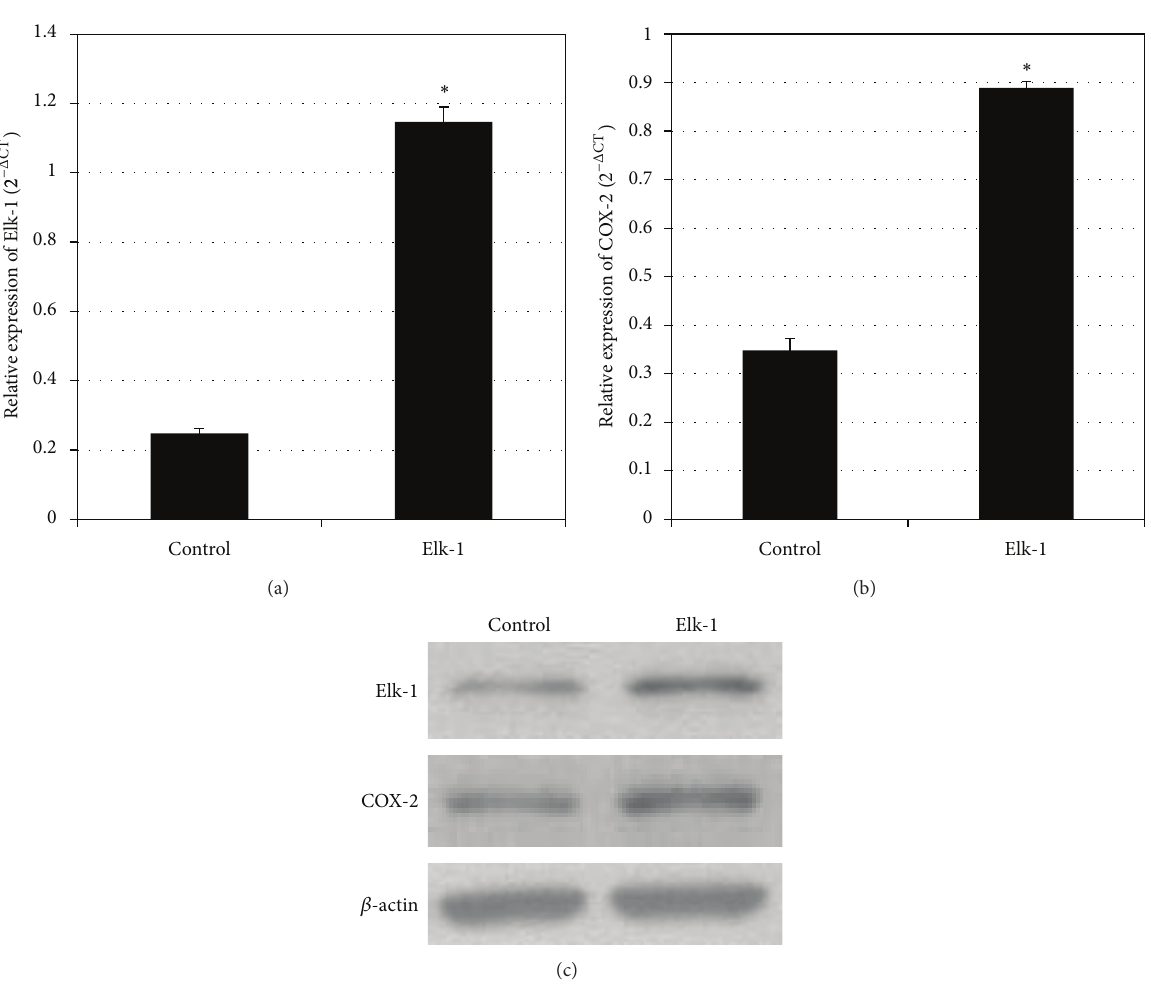
Figure 1: Elk-1 upregulated COX-2 gene expression. (a and b) Elk-1 and COX-2 mRNA levels were determined by quantitative real-time RT- PCR. Relative mRNA expression was expressed as mean ± SEM. ∗ 𝑃 < 0.001 versus control. (c) Elk-1 and COX-2 protein levels were assayed by Western blot analysis. 𝛽 -actin levels served as internal